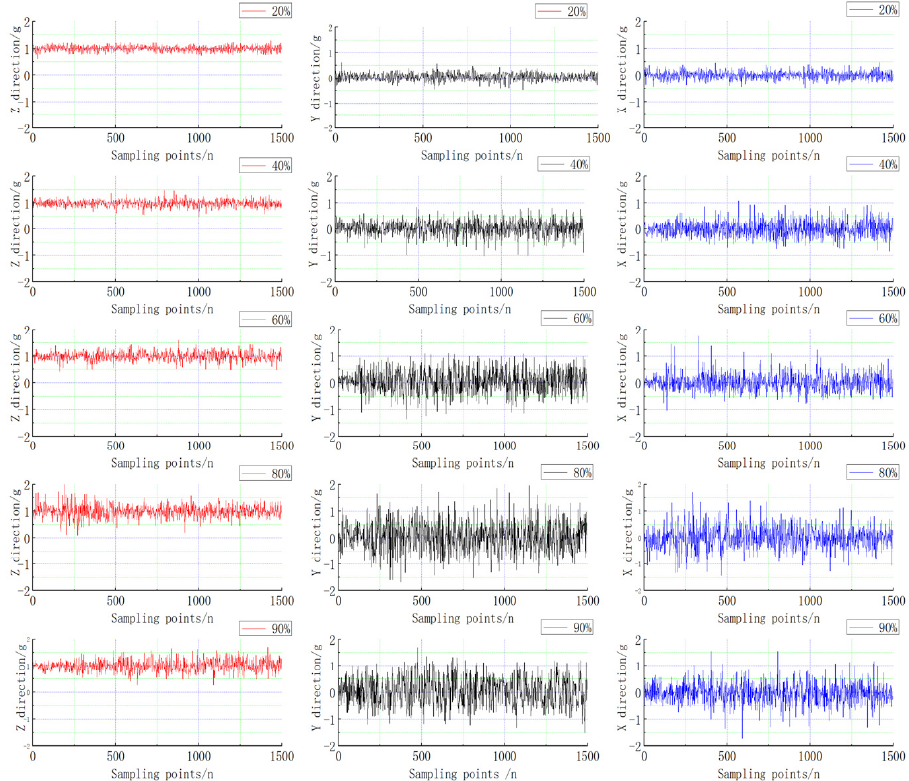
Figure 6. Variation of vibration acceleration in the XYZ direction.